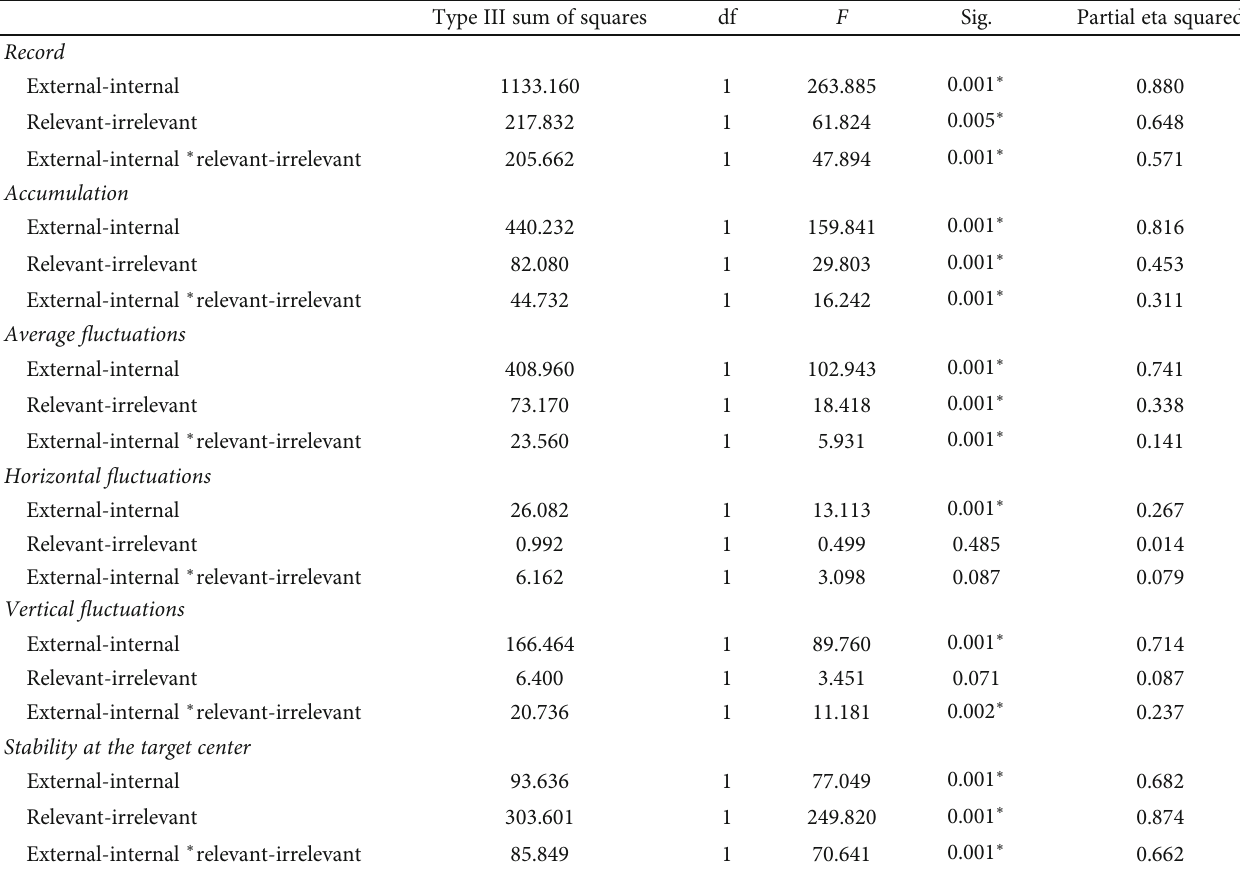
Table 3: Results of factorial [ 2 ð external − internalfocus Þ × 2 ð relevant − irrelevant focus Þ ] analysis of variance repeated measures (ANOVA- RM) for performance precision of military elite shooters in di ff erential attentional focus